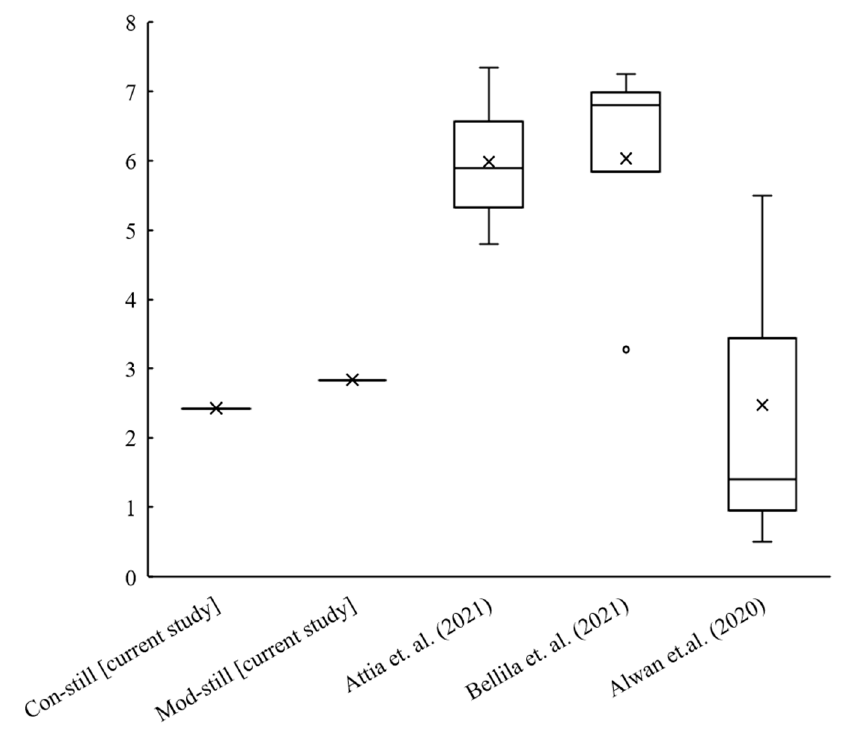
Figure 11. Comparison between results from this study and existing literature. (X indicates average value and 0 indicates outlier.